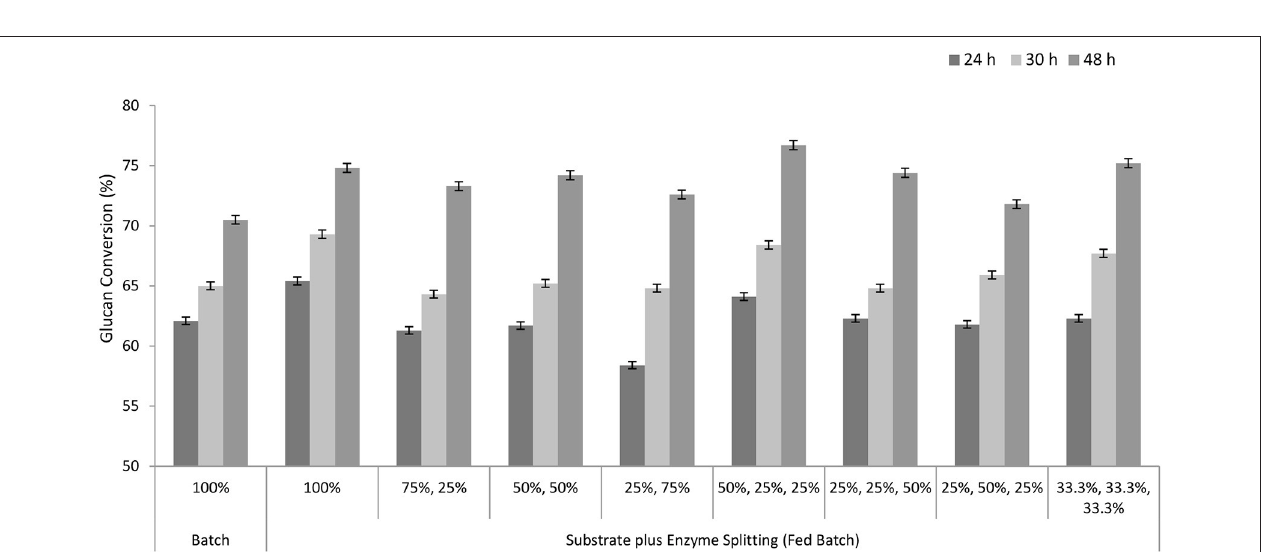
Frontiers in Energy Research | www.frontiersin.org